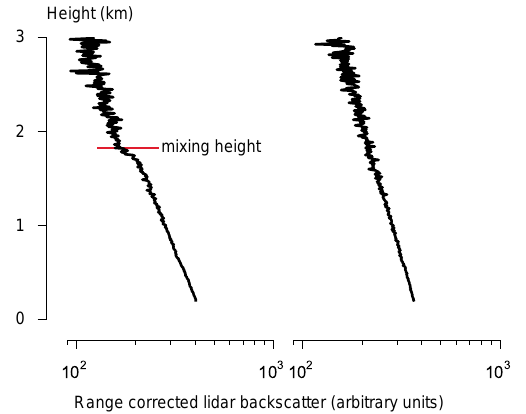
Fig. 2. Lidar profiles (mean of 18000 laser shots) showing an exam- ple with a well defined mixing height (left panel), and one without a detectable aerosol layer (right